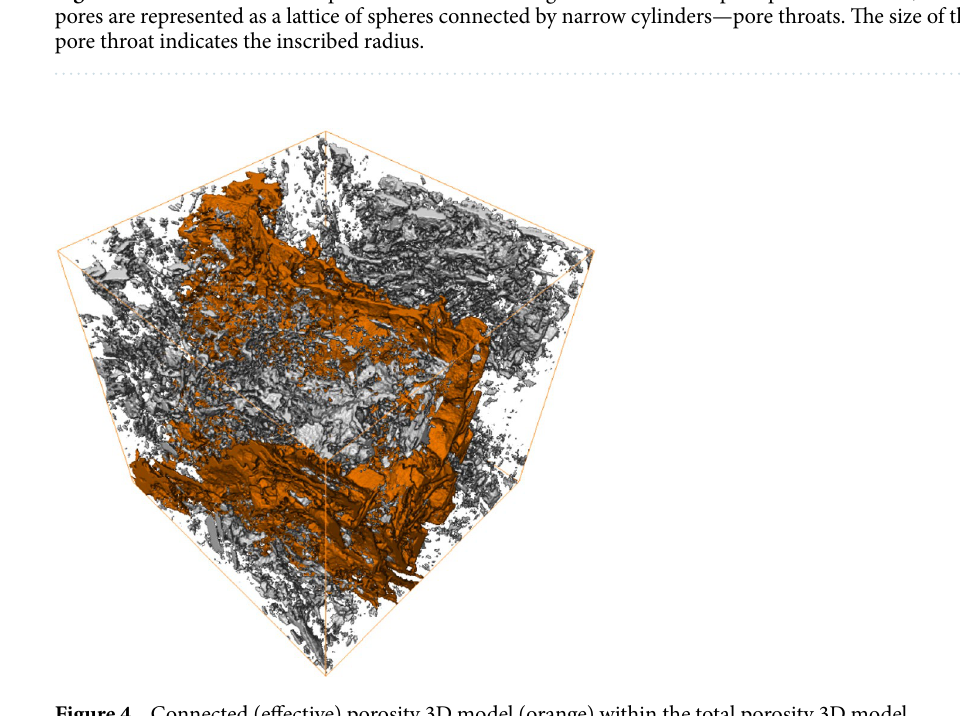
Figure 4. Connected (effective) porosity 3D model (orange) within the total porosity 3D